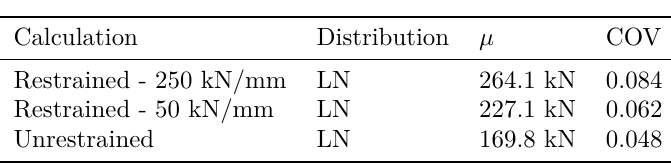
Table 4. Probabilistic models for the ultimate load-carrying capacity F